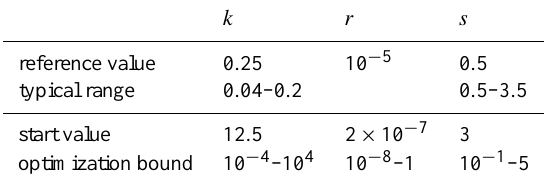
Table 3. Values for the C 3 -model.